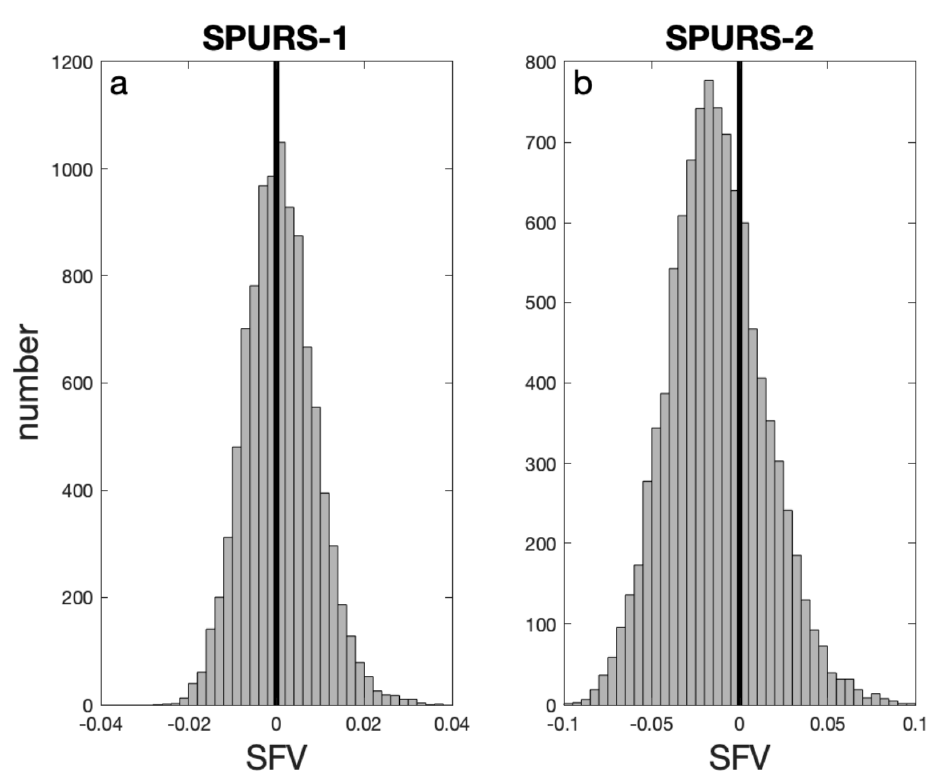
Figure 8. Histograms of mean value of difference between footprint mean SSS and random SSS observations. This is the result of the analysis done in Figure 6 repeated 10,000 times, each time with a different random set of in situ observations. ( a ) SPURS-1. ( b ) SPURS-2. Note different axis scales for each plot.